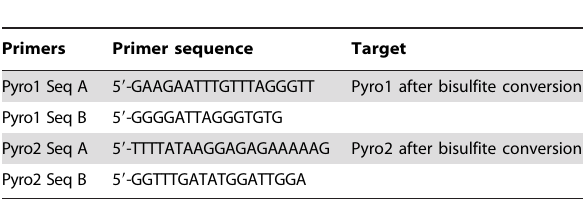
Table 2. Sequencing primers used for low-throughput